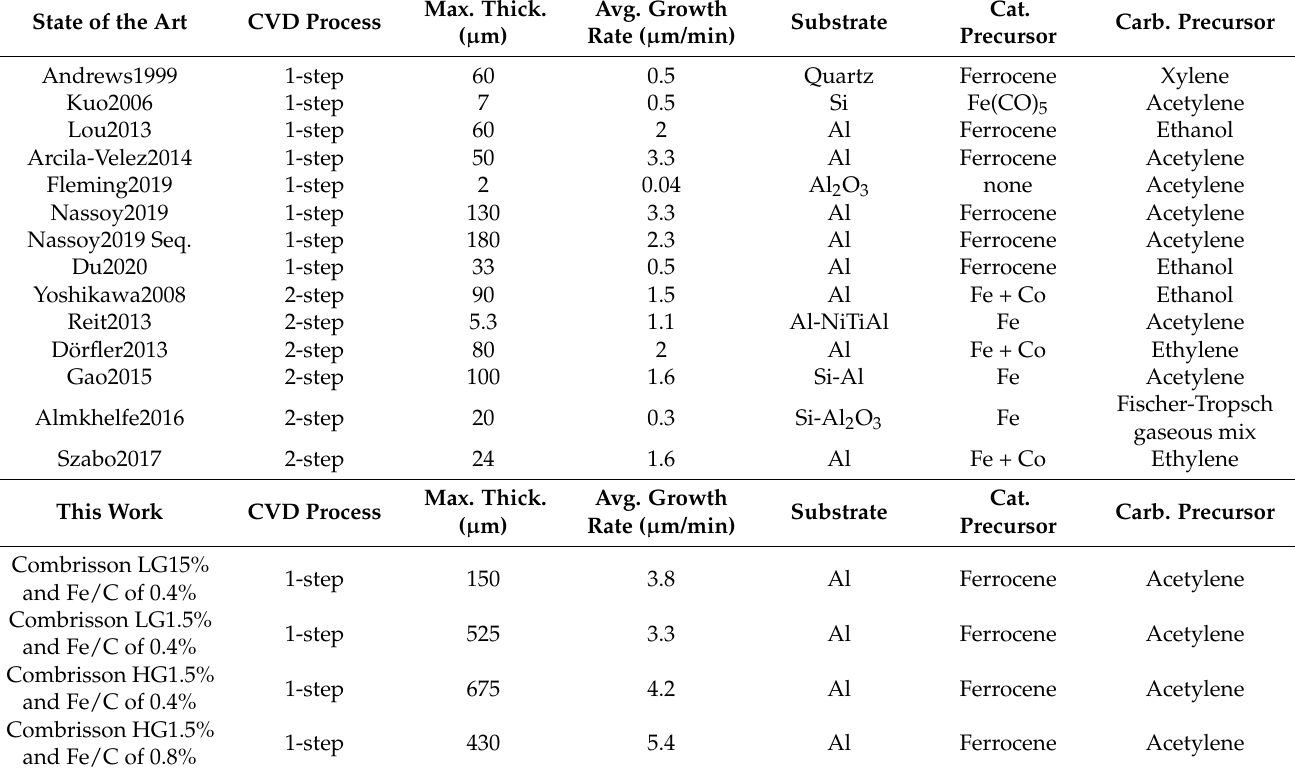
Table 3. State of the art VACNT growth results for low temperature CVD process, mostly performed with iron catalytic precursors and aluminum-based substrates, giving rise to Figure 12. Our results obtained in the present study are also reported at the end of the